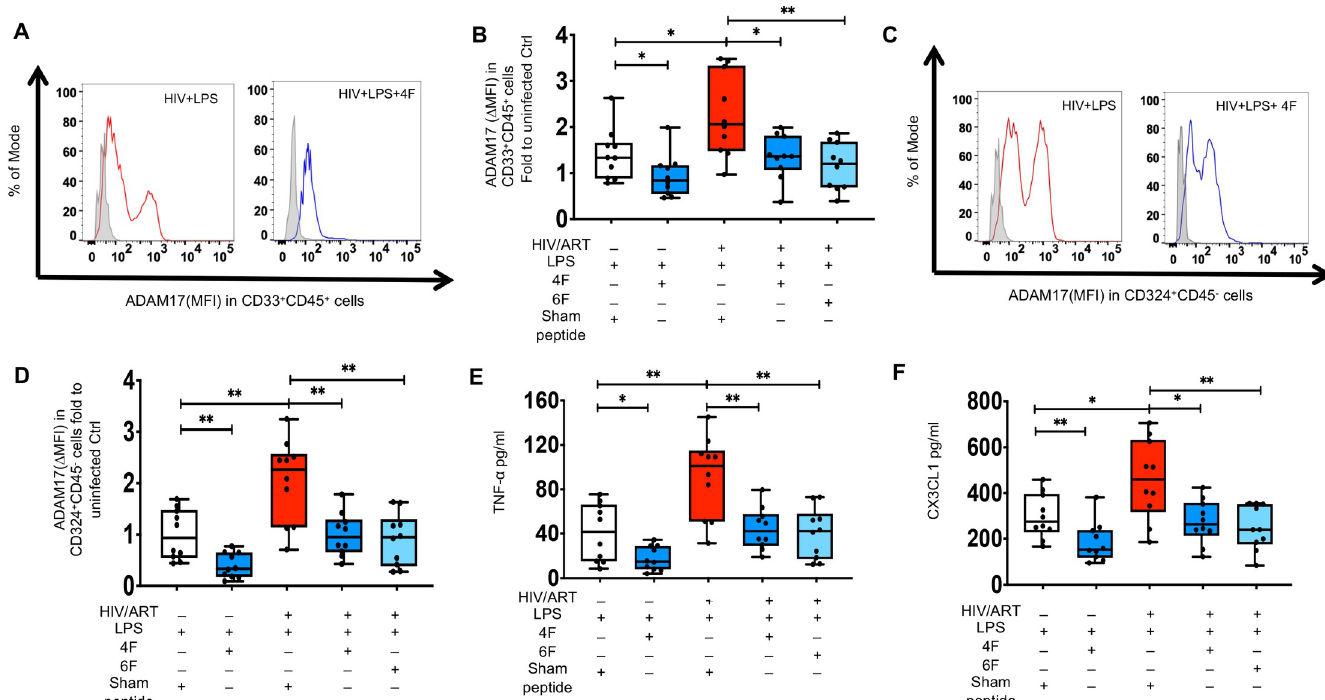
Fig 5. Ex vivo impact of ApoA-I mimetic peptides and endotoxin (LPS) on proteins levels of ADAM17 and associated cytokines and chemokines in gut explants of uninfected and HIV infected participants. Gut biopsies were obtained from uninfected (n = 10) and HIV infected participants on potent ART (n = 10) and gut explants were treated with endotoxin (LPS) for 48 hours and 4F or 6F apoA-I mimetic peptides or sham peptide for 72 hours as in Materials and Methods. Gut biopsies from the same participants were used for experiments with treatments. A-D. Protein levels of A disintegrin and metalloprotease 17 (ADAM17) was detected in myeloid CD33 + CD45 + (A, B ) and CD324 + CD45 - epithelial cells (C, D ) isolated from gut biopsies obtained from uninfected and HIV infected participants treated as shown. A, C . Representative data of flow cytometry data of protein levels (Median fluorescence intensity) of ADAM17 are shown for myeloid CD33 + CD45 + . (A ) and CD324 + CD45 - epithelial cells (C ). Δ MFI represents a shift in median fluorescence intensity of a positive cell population compared to a negative cell population within each sample. The negative cell population was defined based on a fluorescence minus one negative control for staining as shown in light filled grey histogram. B, D. Summary data for protein levels of ADAM17 in intestinal myeloid CD33 + CD45 + ( B ) and CD324 + CD45 - epithelial cells ( D ) from gut biopsies treated as shown. E, F. Supernatants were collected at 72 hours and Luminex immunoassays were used to determine protein levels of cytokines [tumor necrosis factor alpha (TNF- α )]( E) and chemokines [C-X3-C Motif Chemokine Ligand 1 (CX3CL1)] ( F) , that are mediated by ADAM17 sheddase activity. Data represent box and whiskers with minimum, median and maximum values. Datapoints represent mean of 3 gut biopsies per participant. The Mann-Whitney test was used to compare 2 groups ( � p < 0.05, �� p < 0.01, ��� p <